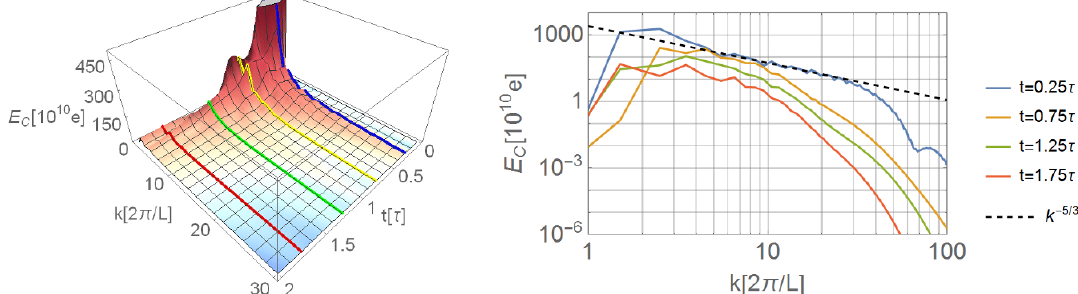
Figure 7 . The energy spectrum for three dimensional (cid:13)ow with an initial Reynolds number of Re (cid:24) 750 initial Mach number of M = 1 and initial mode n = 1. The right plot is an overlay of the energy spectrum at various times. An emergent power law E C ( t; k ) (cid:24) k (cid:0) 5 = 3 is observed at early times and later decays for intermediate values of k